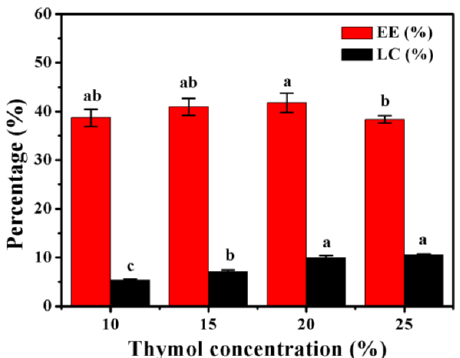
Figure 1. Encapsulation efficiency (EE) and loading capacity (LC) of poly(lactide-co-glycolide) (PLGA) microparticles containing different amounts of thymol. Error bars indicate the standard deviation of the mean. Columns with different letters are significantly different according to Duncan’s multiple range test at P < 0.05.